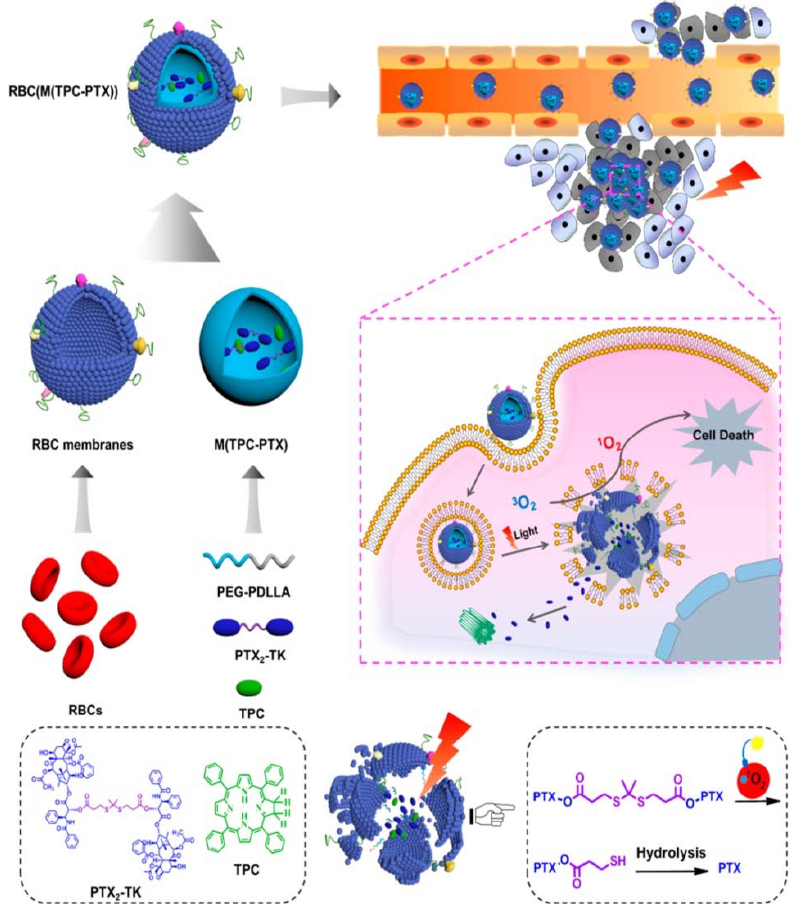
Figure 4. Schematic showing red ‐ blood cell (RBC) membrane ‐ coated dimeric prodrug NPs Schematic showing red-blood cell (RBC) membrane-coated dimeric prodrug NPs (RBC(M(TPC ‐ PTX))); light triggered on ‐ demand drug release and combined chemo ‐ photodynamic (RBC(M(TPC-PTX))); light triggered on-demand drug release and combined chemo-photodynamic therapy. The inner components (i) reactive ‐ oxygen species (ROS) ‐ responsive paclitaxel (PTX) dimer therapy. The inner components (i) reactive-oxygen species (ROS)-responsive paclitaxel (PTX) with thioketal (TK) as the linker and 5,10,15,20 ‐ tetraphenylchlorin (TPC) loaded in dimer with thioketal (TK) as the linker and 5,10,15,20-tetraphenylchlorin (TPC) loaded in methoxypoly(ethylene glycol) ‐ block ‐ poly( D , L ‐ lactide) (PEG ‐ b ‐ PDLLA) NPs for drug retention and methoxypoly(ethylene glycol)-block-poly( D , L -lactide) (PEG- b -PDLLA) NPs for drug retention and light ‐ triggered amplified drug release; (ii) RBC membrane ‐ based outer shell for long blood light-triggered amplified drug release; (ii) RBC membrane-based outer shell for long blood circulation. circulation. Reproduced with permission from Ref [67]. Copyright © 2018 American Chemical Society. Reproduced with permission from Ref [67]. Copyright © 2018 American Chemical